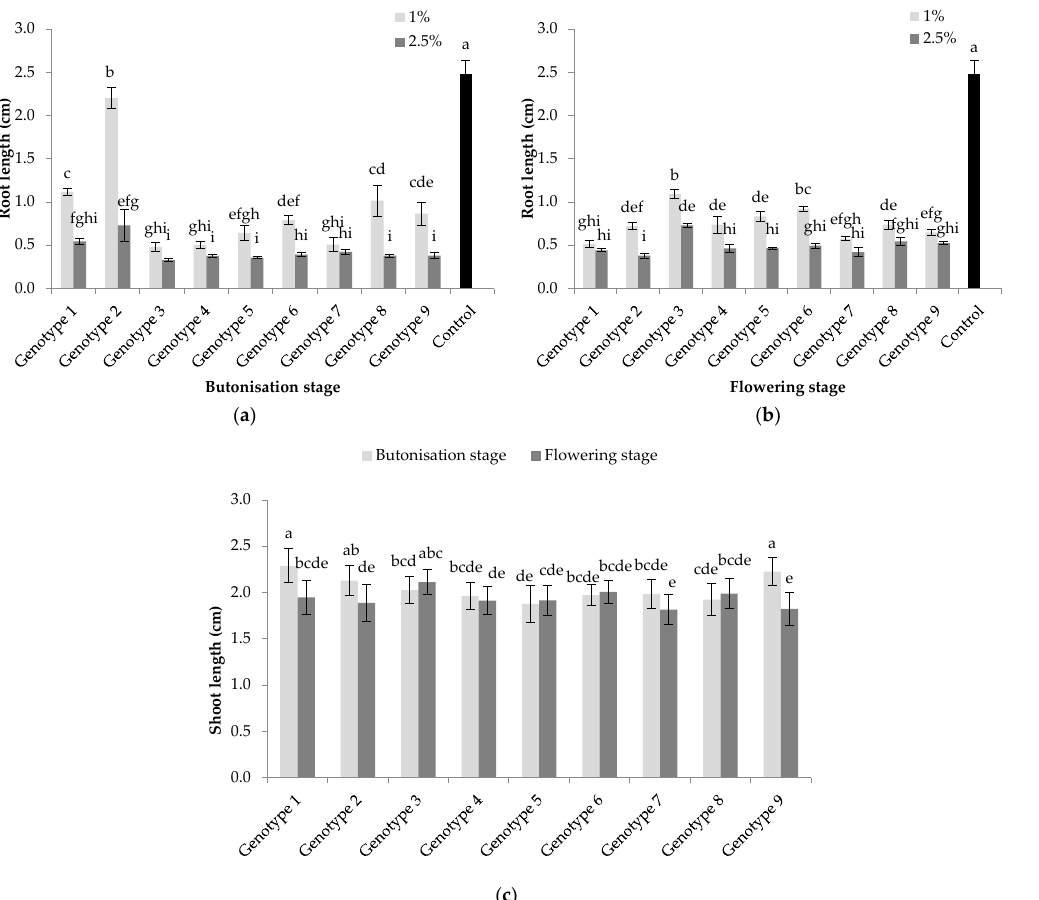
Figure 2. Allelopathic effect of water extracts from sunflower leaves collected in the butonisation and flowering stage on the root ( a , b ) and shoot ( c ) length of lettuce seedlings. Columns with the same letters are not significantly different at p < 0.05.